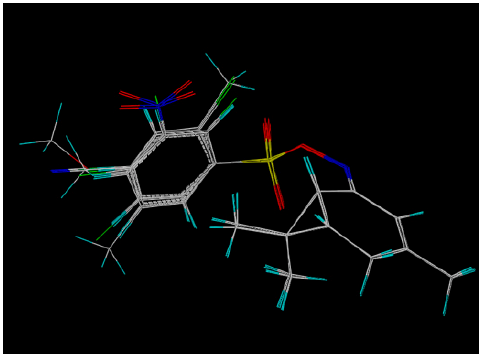
Figure 5. Superposition modes of compounds.